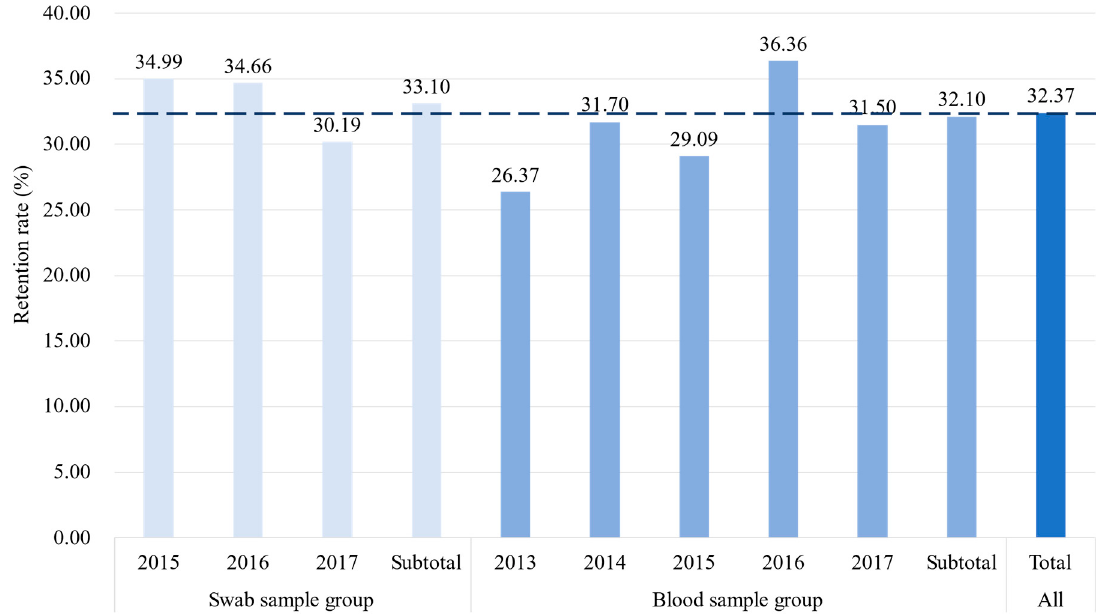
Figure 2. Telephone follow-up results of HSCD volunteers.